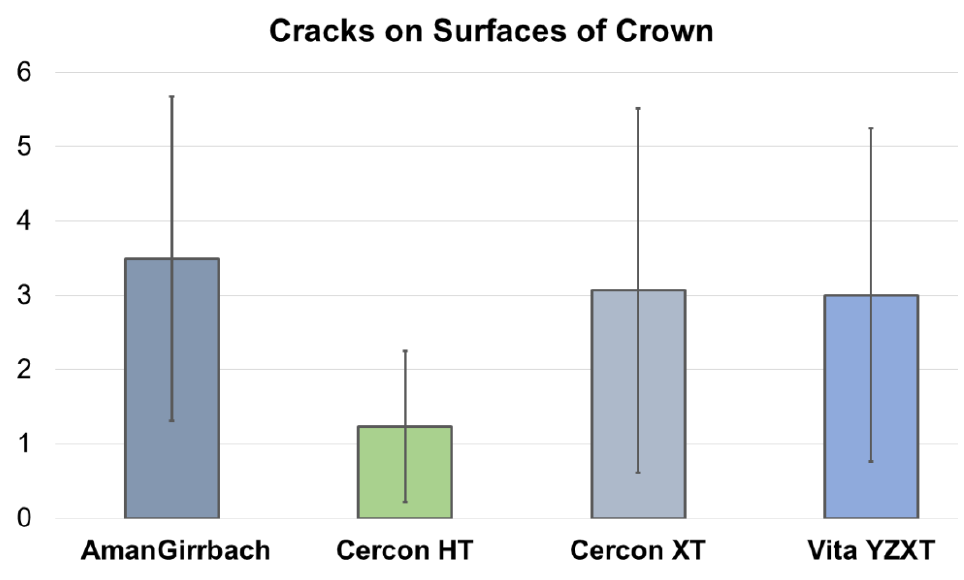
Figure 4. Cracks on surfaces of zirconia crowns.